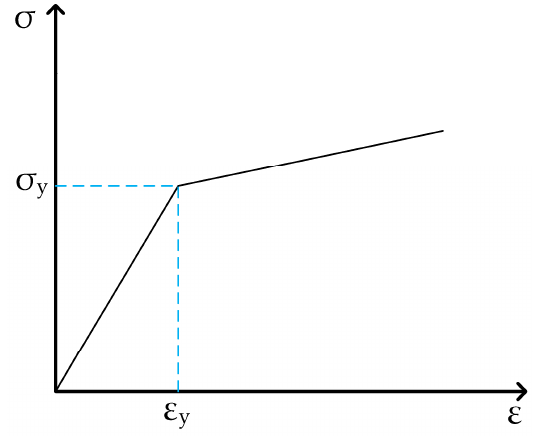
Figure 2. Bilinear kinematic hardening model of Q355.